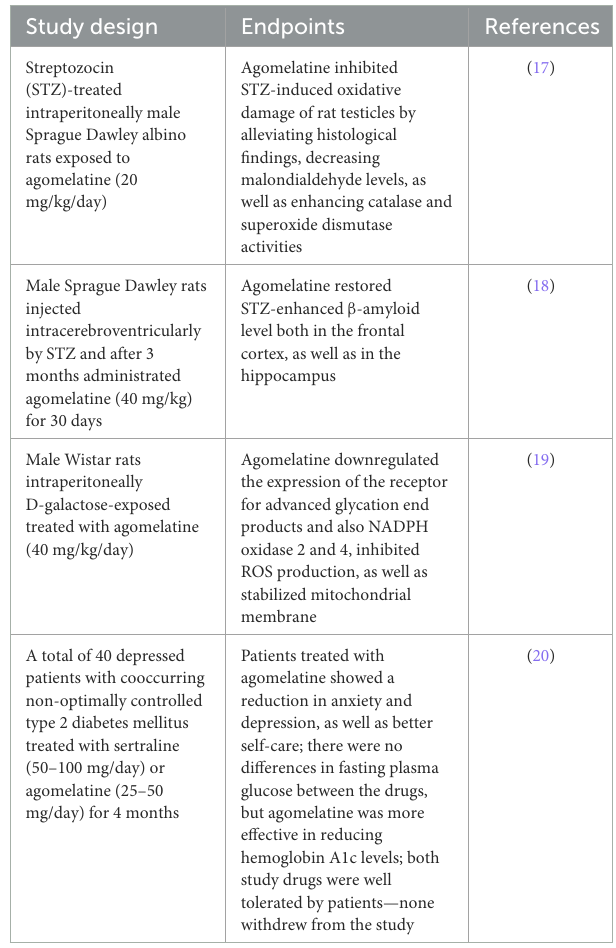
TABLE 2 Agomelatine’s antiglycoxidative action in experimental and clinical